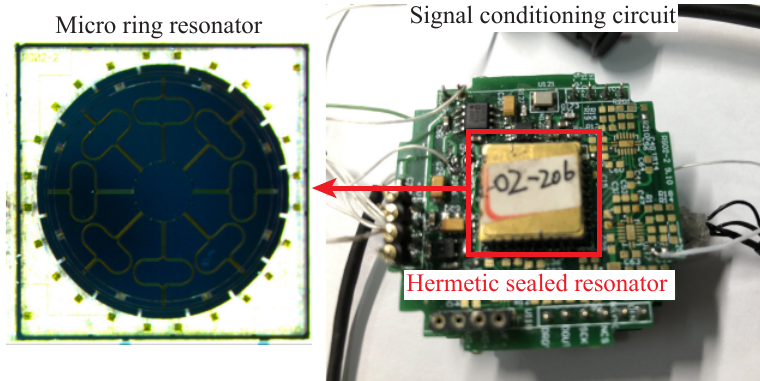
Figure 13. The ring resonator and the signal conditioning circuits.